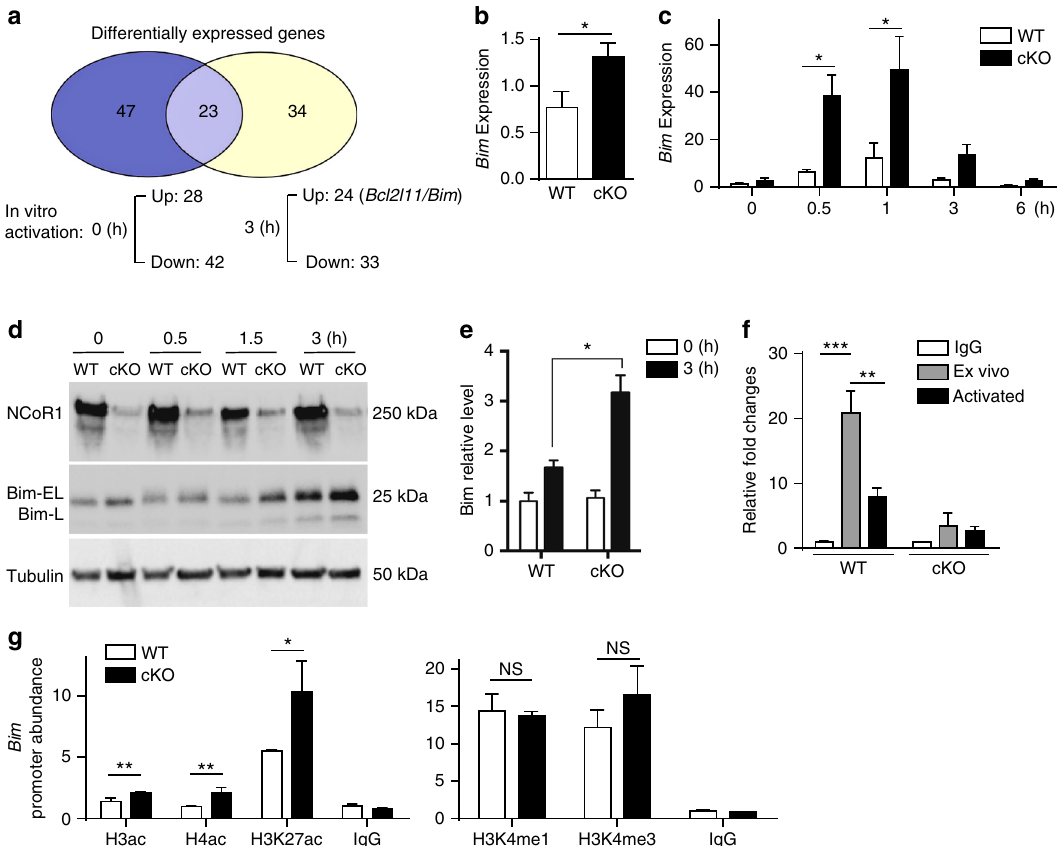
Fig. 5 NCoR1 binds to the Bim promoter and represses Bim expression. a RNA-Seq analysis of differentially expressed genes in NCoR1-de fi cient (cKO) and wild-type (WT) thymocytes with or without activation in vitro. b , c Quantitative RT-PCR analysis of Bim mRNA expression in freshly sorted cKO ( n = 6) and WT ( n = 6) CD4 + CD8 + double-positive (DP) thymocytes ( b ), and in total cKO ( n = 4) and WT ( n = 4) thymocytes ( c ) after in vitro TCR stimulation for the indicated amounts of time. d Immunoblot analysis of NCoR1 and Bim expression levels in extracts of cKO and WT thymocytes with or without stimulation for the indicated amounts of time. e Quanti fi cation of NCoR1 and Bim expression levels in ( d ). f ChIP analysis of the Bim promoter by anti- NCoR1 in cKO and WT thymocytes with or without activation in vitro. IgG served as a negative control. g ChIP analysis of the Bim promoter in cKO and WT thymocytes using the indicted antibodies. The data are representative of two independent experiments ( b , c , f , g ). Statistical signi fi cance was analyzed using the two-tailed Student ’ s t test (* P < 0.05; ** P < 0.01; *** P < 0.001; NS, not signi fi